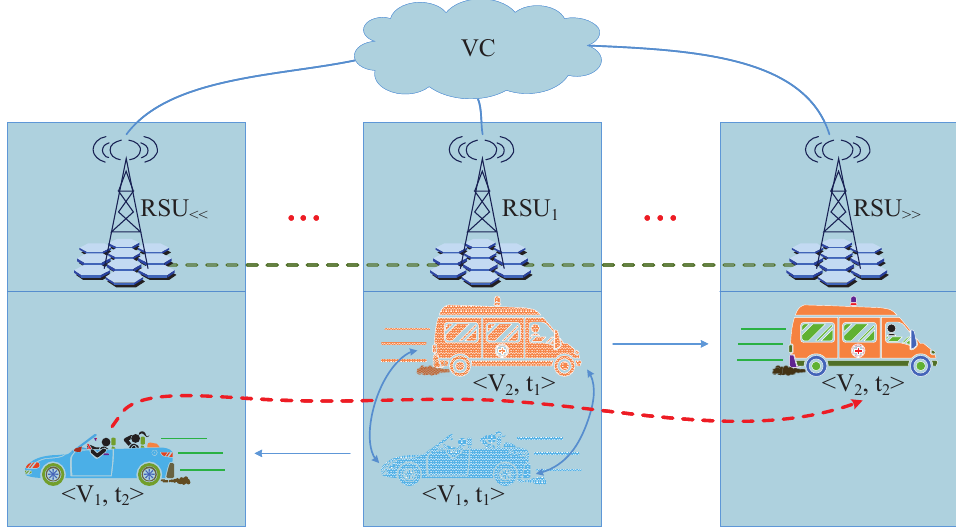
Figure 2. RSU-aided remote V2V message